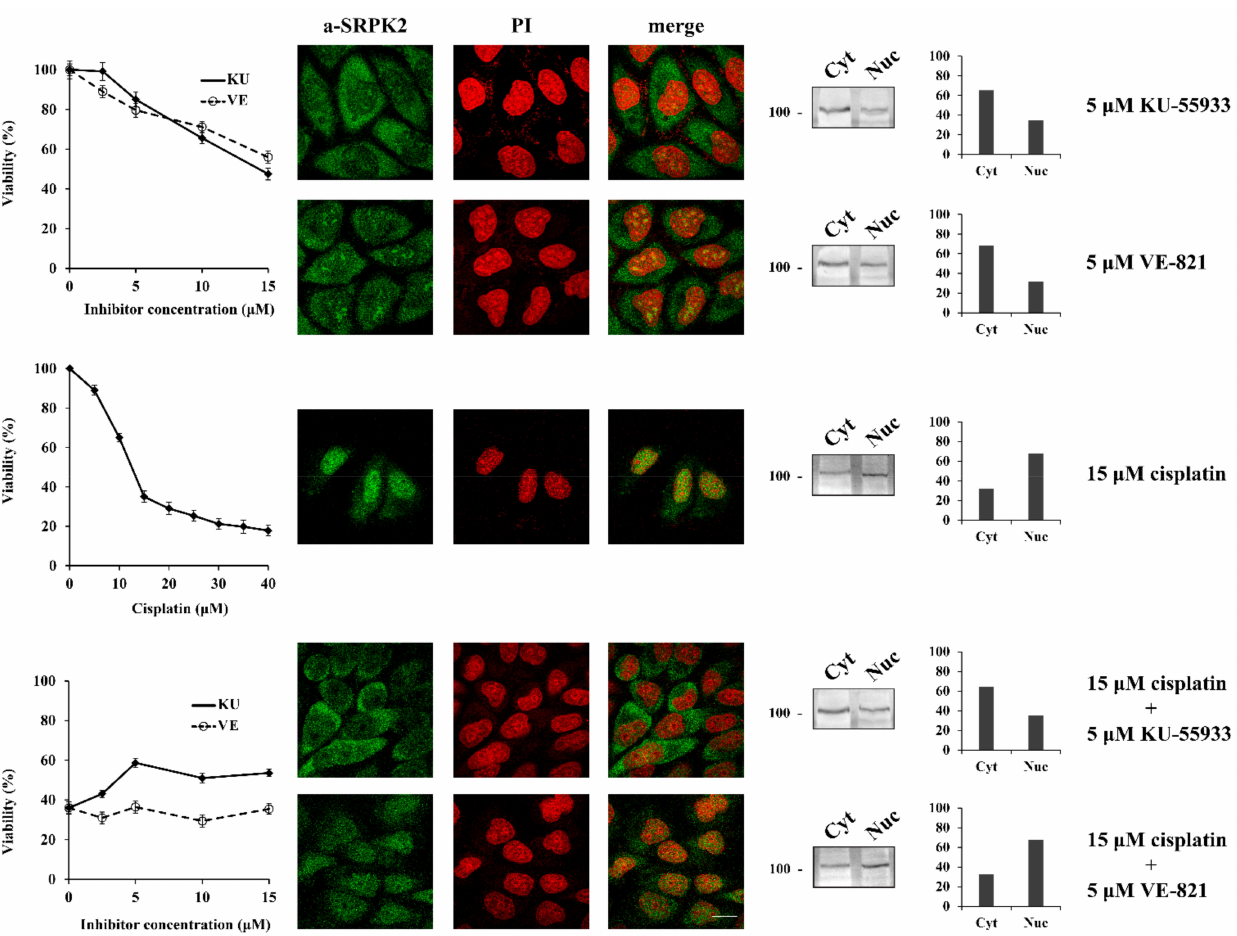
Figure 2. ATM inhibition prevents the nuclear translocation of SRPK2 in cisplatin-treated cells and partially protects the cells from drug cytotoxicity. HeLa cells were treated with increasing concentrations of KU-55933 (2.5–15 µ M) alone, VE-821 (2.5–15 µ M) alone, cisplatin (5–40 µ M) alone, and cisplatin (15 µ M) combined with increasing concentrations of KU-55933 (2.5–15 µ M) or VE-821 (2.5–15 µ M) for 24 h. The number of viable cells was measured with an MTT assay ( left panel ). Viable cells were quantified by normalizing the absorbance readings to the untreated control cells, which was set as 100% viability. Correspondingly, the figure shows fluorescent patterns of SRPK2 in HeLa cells treated for 24 h with KU-55933 (5 µ M) alone, VE-821 (5 µ M) alone, cisplatin (15 µ M) alone, and cisplatin (15 µ M) combined with KU-55933 (5 µ M) or VE-821 (5 µ M) ( middle panel ). SRPK2 was detected using the anti-SRPK2 monoclonal antibody, while nuclei were stained with PI. Scale bar: 10 µ m. The distribution of SRPK2 after each treatment was also determined by a cell fractionation procedure ( right panel ). SRPK2 was detected in cytoplasmic (Cyt) and nuclear (Nuc) extracts by Western blotting using the anti-SRPK2 monoclonal antibody. The nuclear-to-cytoplasmic SRPK2 ratios in the Western blots shown were quantified using ImageJ